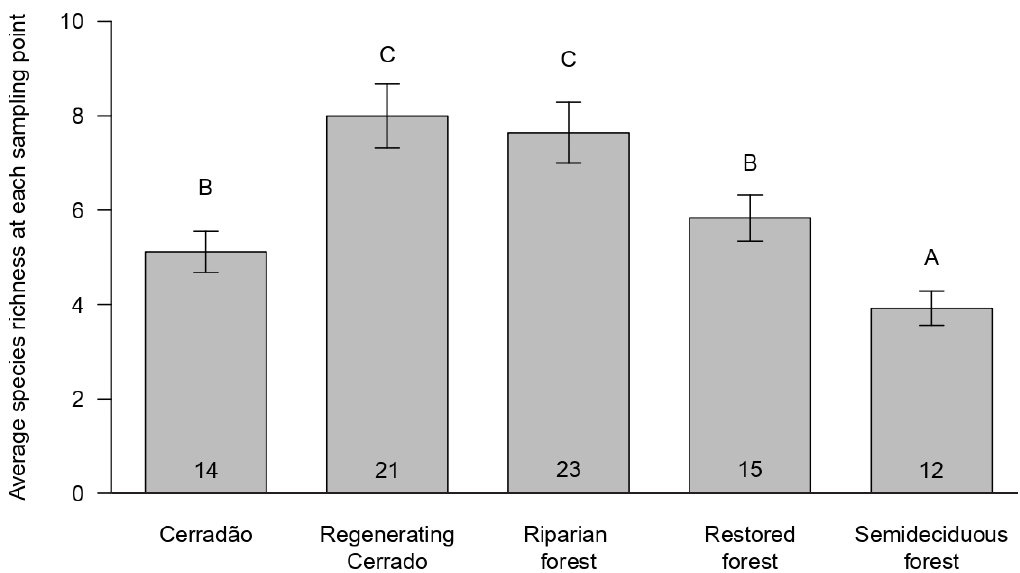
Fig 3 . Species richness of social wasps collected for each point in each type of vegetation. The number inside the bars indicates a total richness for each vegetation. Different capital letters represent significant